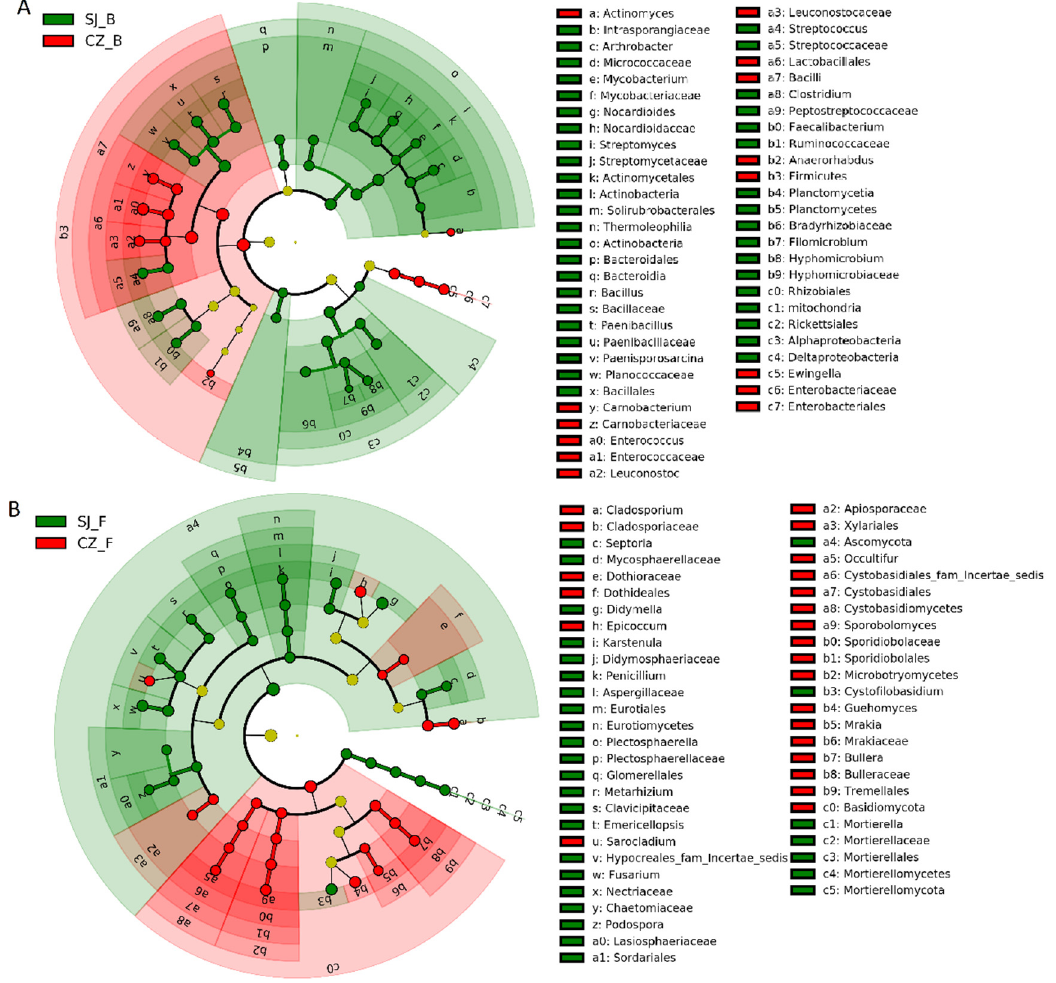
Figure 5. LEfSe analysis of the intestinal bacterial biomarkers ( A ) and fungal biomarkers ( B ) of Hood cranes at Caizi and Shengjin Lake group. Identified phylotype biomarkers were ranked by effect size and the alpha value was < 0.05. Each filled circle represents one biomarker. Cladogram represents the taxonomic hierarchical structure from phylum to genus of the biomarkers identified; Red, phylotypes statistically overrepresented in gut of Hooded Cranes at Caizi Lake; Green, phylotypes statistically overrepresented in gut of Hooded Cranes at Shengjin Lake; Yellow, phylotypes for which relative abundance is not significantly different among three lakes. CZ: Caizi Lake; SJ: Shengjin Lake; B: bacteria; F: fungi.